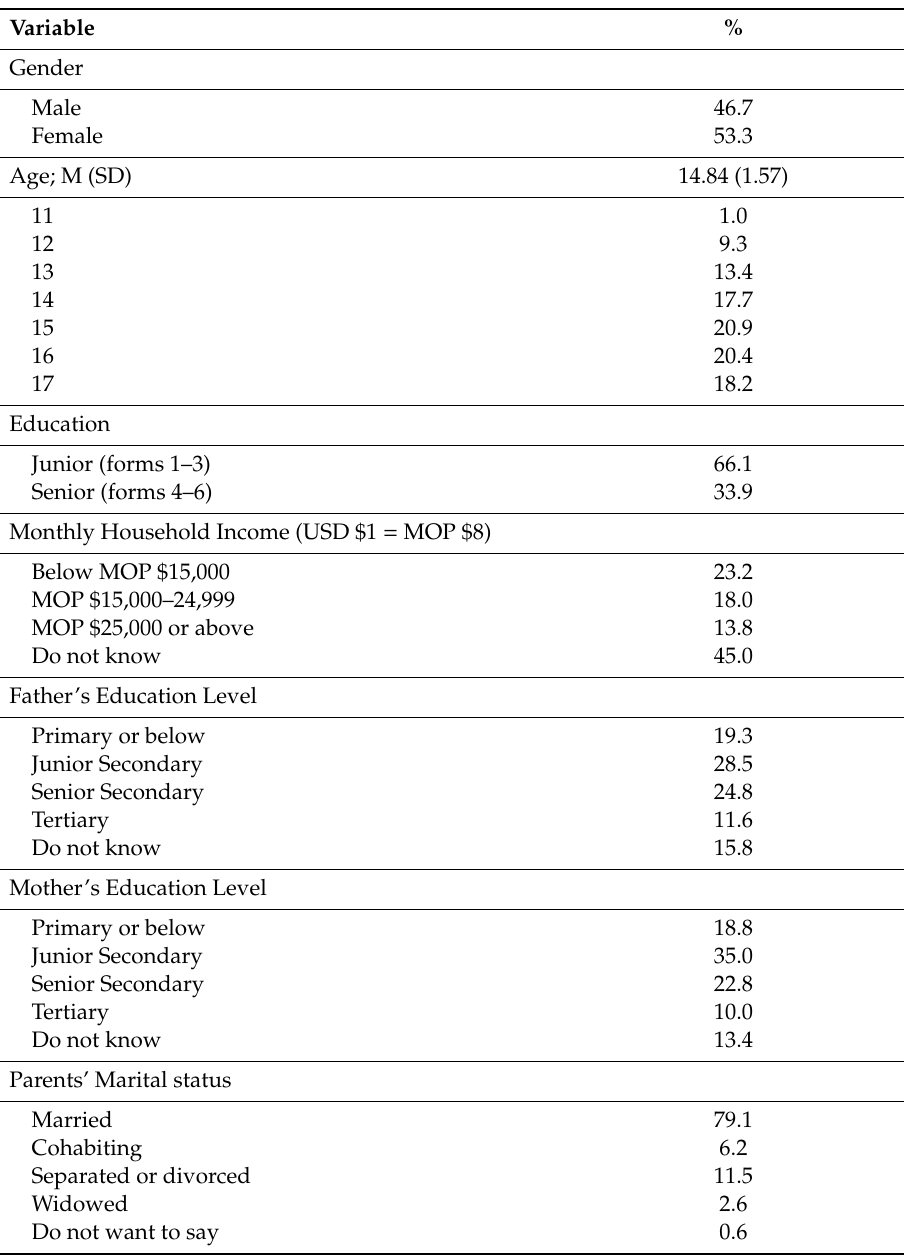
Table 1. Sample characteristics ( n =